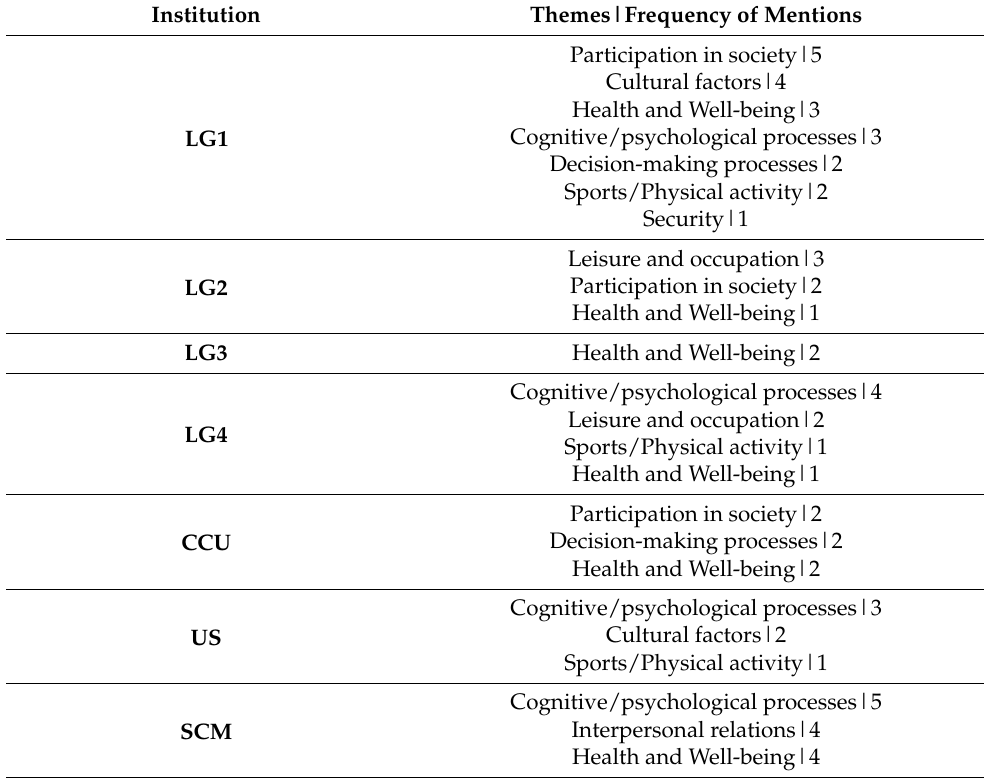
Table 3. Dimensions of Active